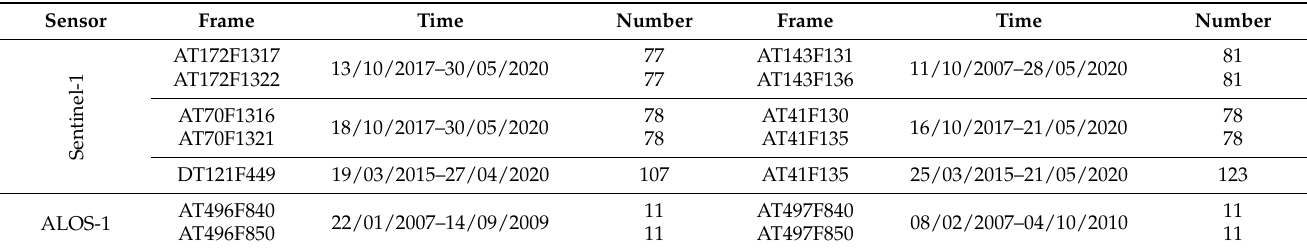
Table 1. Acquisition periods of the